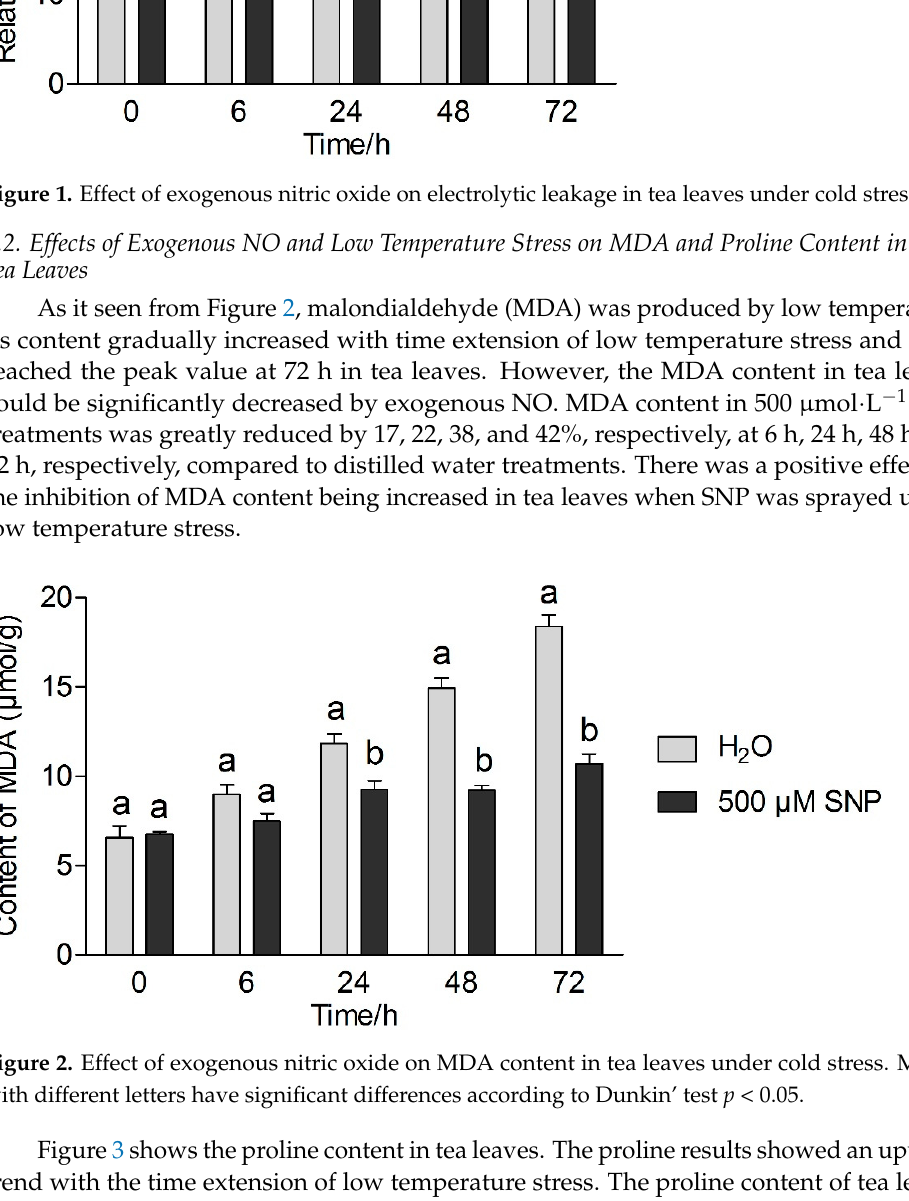
Figure 1. Effect of exogenous nitric oxide on electrolytic leakage in tea leaves under cold stress.